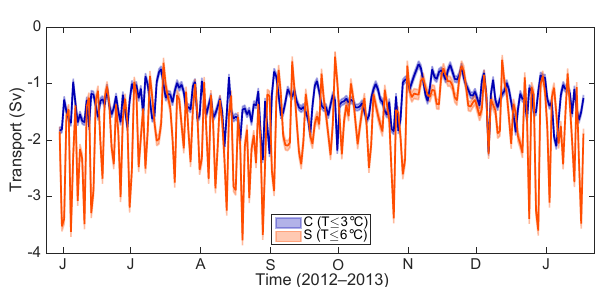
Figure 7. Time series of daily volume transport through mooring sections C (blue) and S (red). The transport at C includes water with temperature up to 3 ◦ C and at S up to 6 ◦ C. Shading shows the standard error for each time